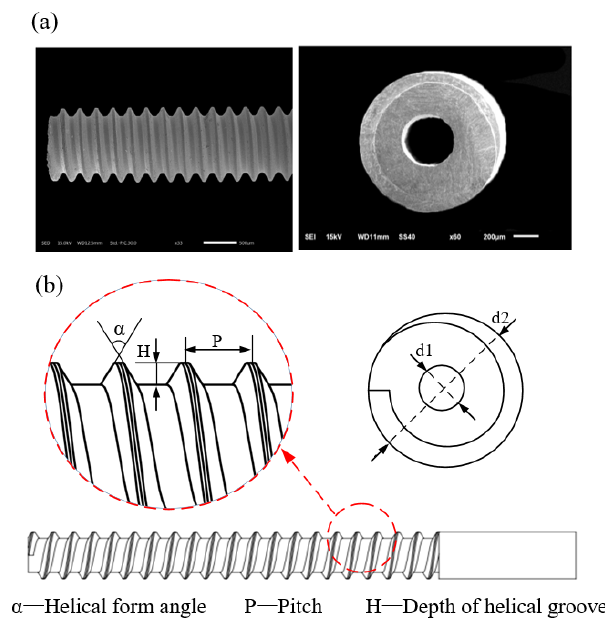
Figure 2. ( a ) Physical images of the trapezoidal helical tube electrode and ( b ) geometric parameters of the helices.